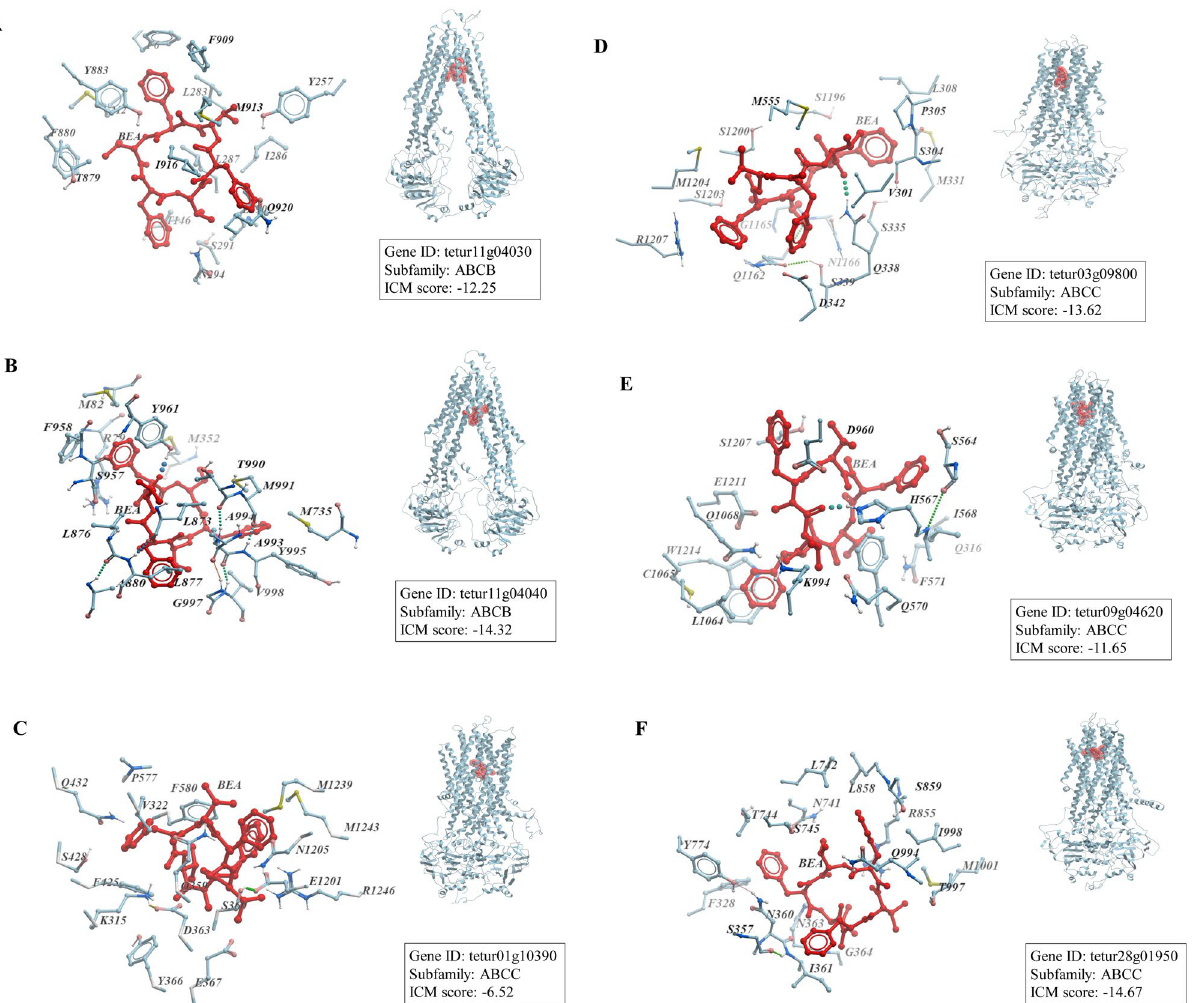
Figure 3. The binding model of BEA against ABC transporters. Interactions between BEA (red) and associated residues (blue) in the interface of the homology models for ABC transporters belonging to the ABC transporter subfamilies B ( A : tetur11g04030; B : tetur11g04040) and C ( C : tetur01g10390; D : tetur03g09800; E : tetur09g04620; F :